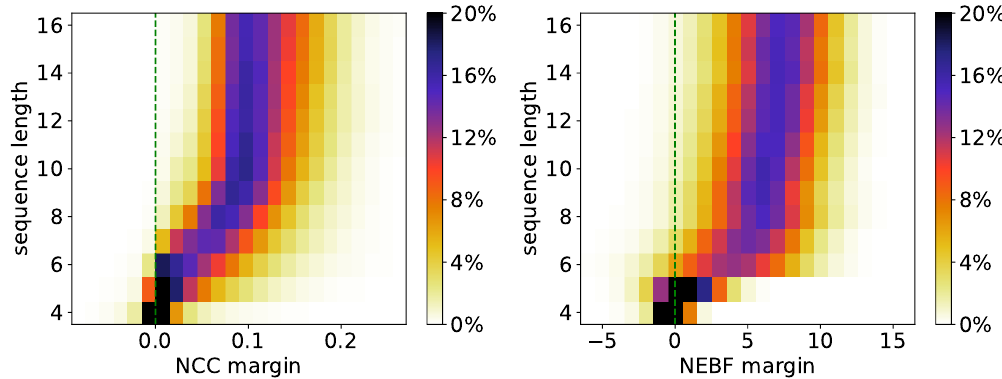
Figure 12. Histogram of margins of the NCC ( left ) and the NEBF ( right ) at the true correspondence vs. the most similar pixel amongst the wrong correspondences. Large positive values mean that the true correspondence can be well distinguished from wrong correspondence candidates. Negative